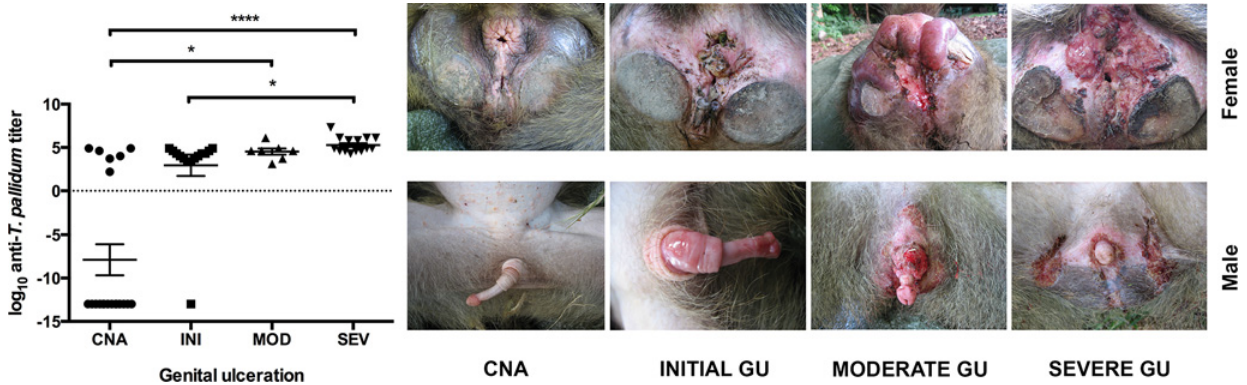
Fig 1. Multiple comparisons of log anti- T . pallidum titers in 4 groups with a different stage of genital ulceration in baboons ([CNA] = clinically non- affected (n = 20), [INI] = initial (n = 14), [MOD] = moderate (n = 7), and [SEV] = severe genital ulceration (n = 16); for stage definition see [18]), GU = genital ulceration. Anti- T . pallidum antibody quantification was investigated using the Serodia TP-PA. Kruskal-Wallis test using Dunn ’ s correction for multiple comparison: CNA vs. SEV mean rank diff. = -30.04, p (cid:3) 0.0001; CNA vs. MOD mean rank diff. = -19.95, p (cid:3) 0.05; INI vs. SEV mean rank diff. = -17.56, p (cid:3) 0.05. (mean ±